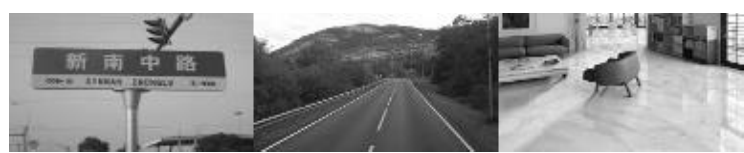
Figure 4. Positive sample picture.